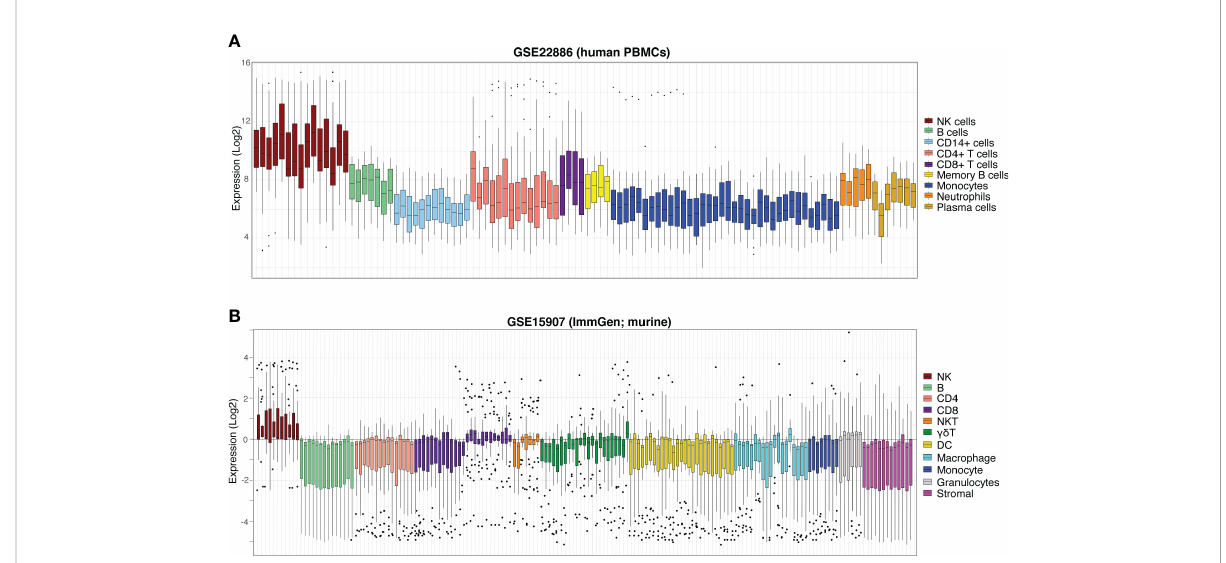
FIGURE 5 NK cell signature ef fi ciently discriminates NK cells from other haematopoietic compartments. Boxplots of NK cell signature expression in sorted peripheral blood cells from (A) GSE22886 (Log2) independent human PBMC data and (B) GSE15907 (Immgen) murine data. Each boxplot represents one sample (coloured by cell type, at right) and individual points are single signature